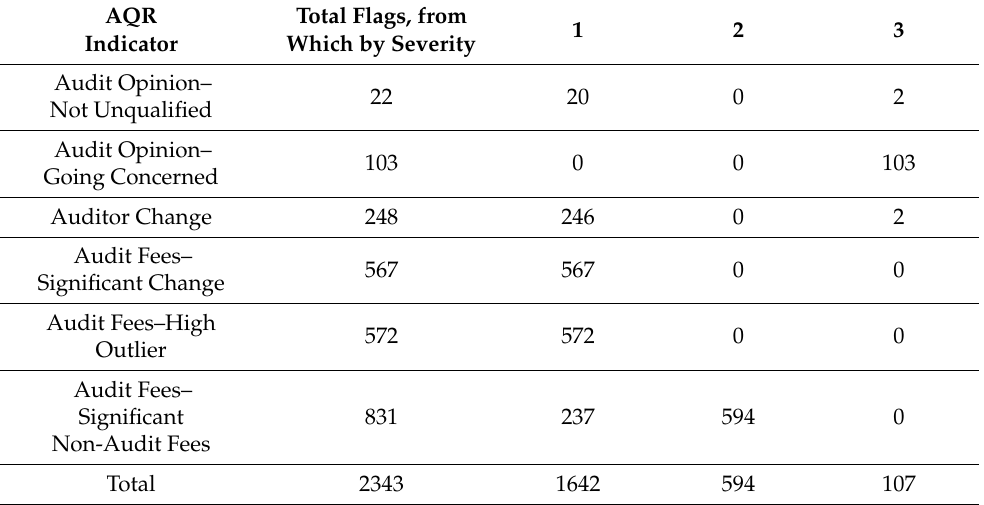
Table 4. AQR Indicator